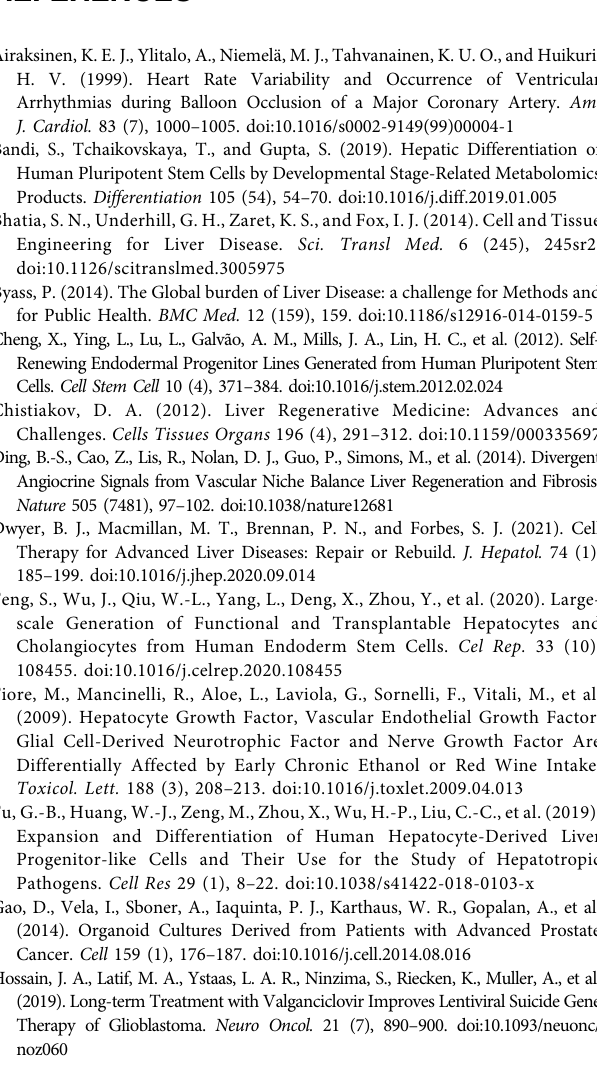
Supplementary Figure S4 | Rifampicin enhanced CYP3A4 expression. (A) IF analysis ofCYP3A4 expression in HepLPCs after Rifampicin treatment for 72 h. Scale bar, 100 µm. Supplementary Figure S5 | Transplantation of vHepLPC spheroids promoted functional recovery in mice with acute liver injury. (A) Survival curve for acute liver injury mice with HepLPCs ( n (cid:2) 11), vHepLPCs ( n (cid:2) 10), or without ( n (cid:2) 11) spheroid transplantation. (B) Serum levels of ALT and AST in CCL4-treated mice before ( − 1) and after transplantation (days one through seven) of spheroids. (C) H&E and immunohistochemistry staining for Ki67 after transplantation of human spheroids on day two and day thirty. Data are presented as means ± SEM. Scale bars, 100 µm. Supplementary Figure S6 | Troglitazone inhibited CDFDA excretion by destroying hepatocytes. (A) Live-imaging of CDF in vHepLPCs incubated with troglitazone (80 μ M)for6 h. (B) ALBandKRT7wereanalyzedbyqRT-PCR.Dataarenormalized to the DMSO group. Data are presented as means ± SEM. * p < 0.05. Scale bar, 100 µm. SupplementaryFigureS7| ScreeningHUVECs-derivedfactors. (A) HUVECswere screened for derived cell factors using qRT-PCR. Data are presented as means ± SEM. * p <